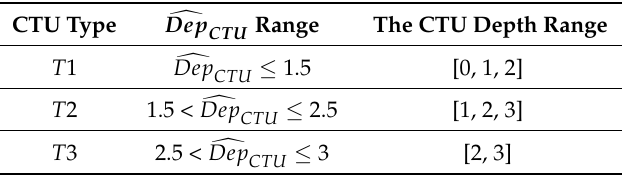
Table 1. The CTU depth